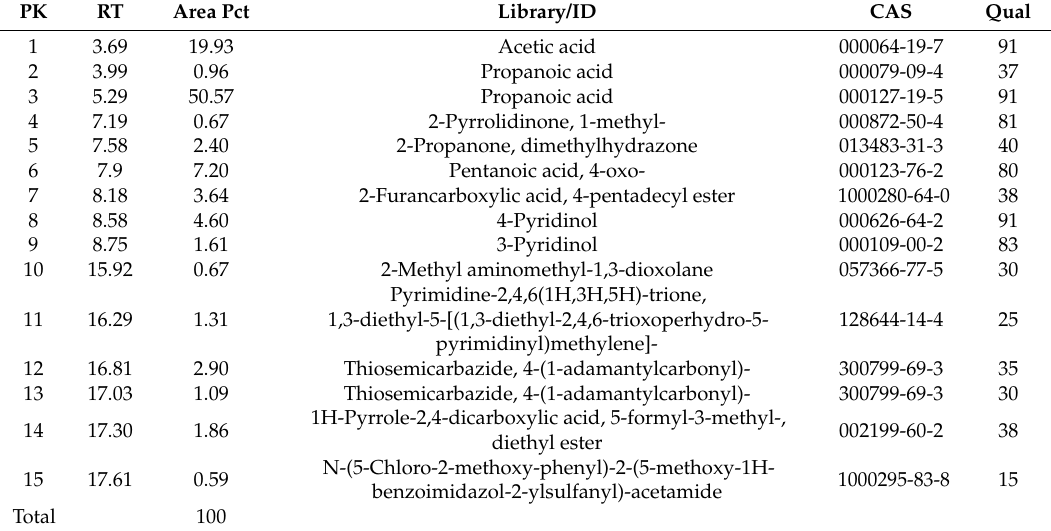
Table 4. GC-MS results of the aqueous fraction of bio-crude oil obtained from HTL of TPW in water–ethanol medium at 250 ◦ C, 30 min with H 2 SO 4 catalyst.